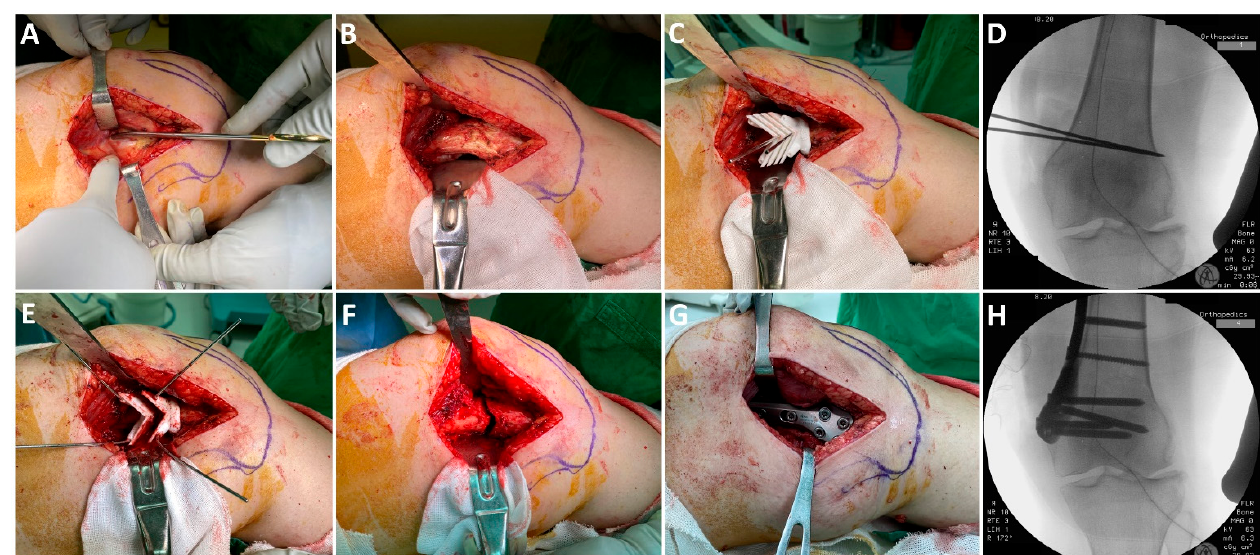
Figure 3. The surgical approach and the intraoperative radiographs. ( A ) A standard medial approach to the distal femur was used, utilizing the plane between the vastus medialis and adductors (distal is to the right and proximal is to the left). ( B ) The periosteum was elevated from the target femoral surface. The posterior femoral structure was retracted with a Bennett retractor in protection of the neurovascular bundle. ( C ) The customized cutting jig was placed onto the medial cortex, identifying the ideal spot with an anatomical fit of the guide. Two orientation K-wires were then inserted through the K-wire holes at the apexes of the chevron cut. ( D ) Positioning of the orientation K-wires was confirmed with a C-arm. ( E ) Four K-wires were inserted, fixing the guide onto the bone. Osteotomy was performed with a graduated oscillating saw. ( F ) The cutting guide and the wedge were removed after the osteotomy. ( G ) The osteotomy was then closed with gentle manual bending and fixed with the associated locking plate system. ( H ) The final position of the plate was confirmed with a C-arm. An alignment rod was not used.